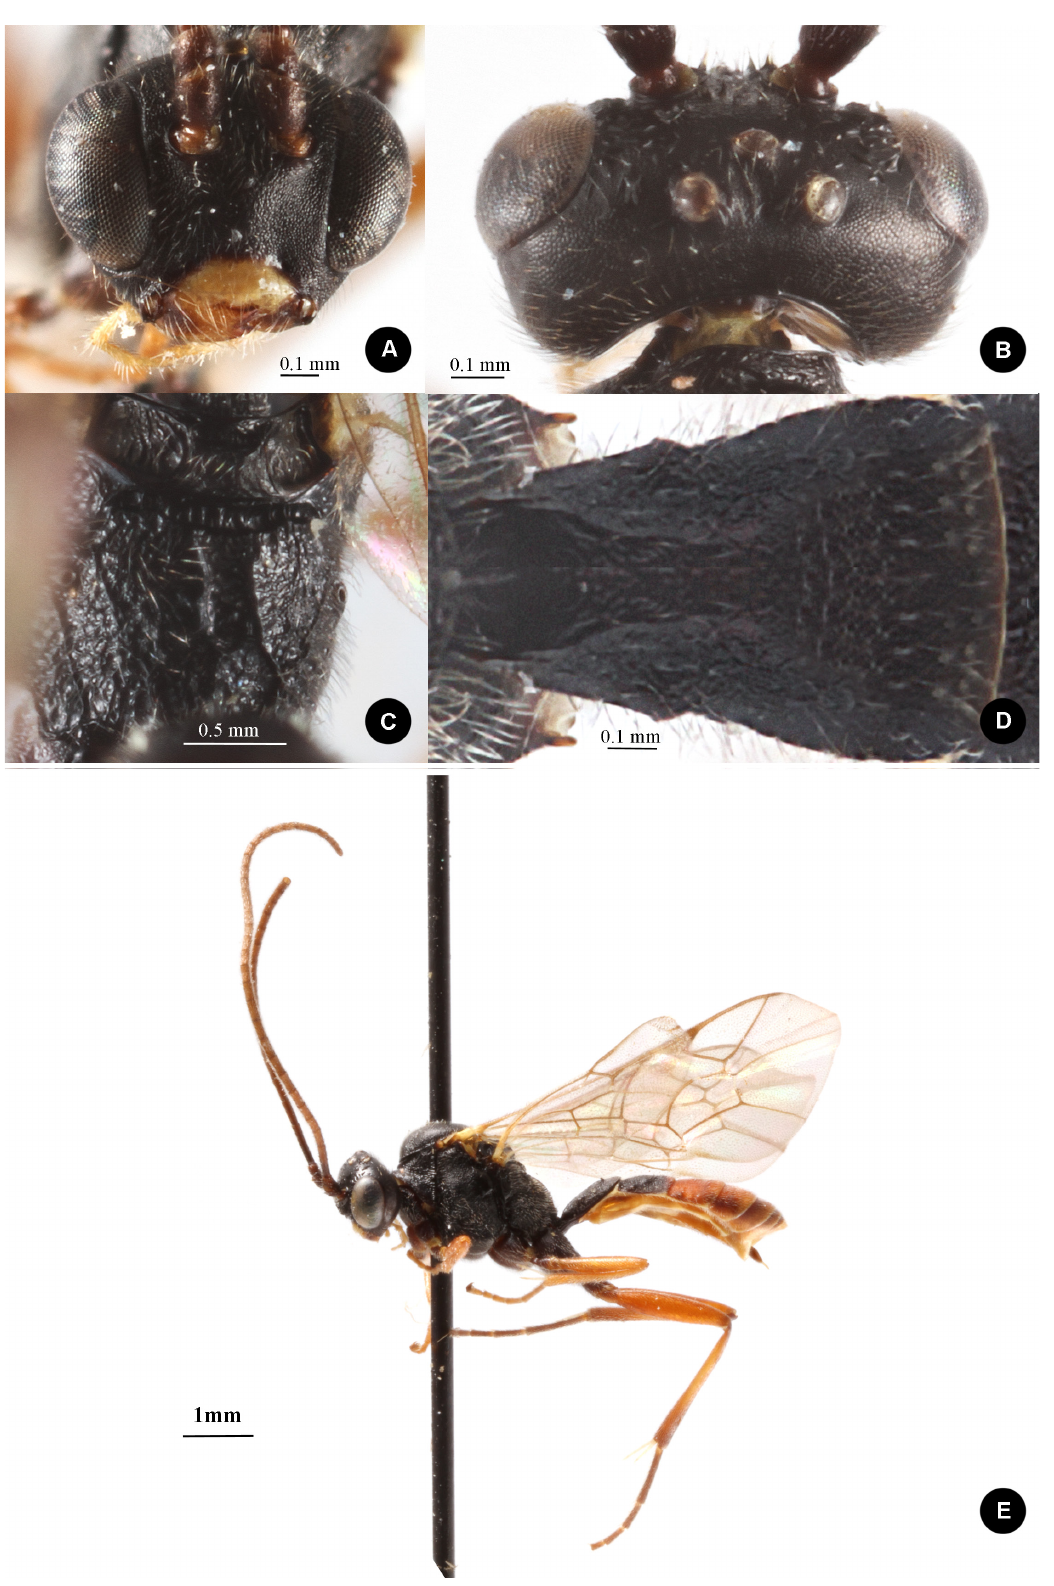
Fig. 10. Rhinotorus nasutus (Gravenhorst, 1829). A . Face. B . Head dorsally. C . Propodeum. D . First metasomal tergite dorsally. E .